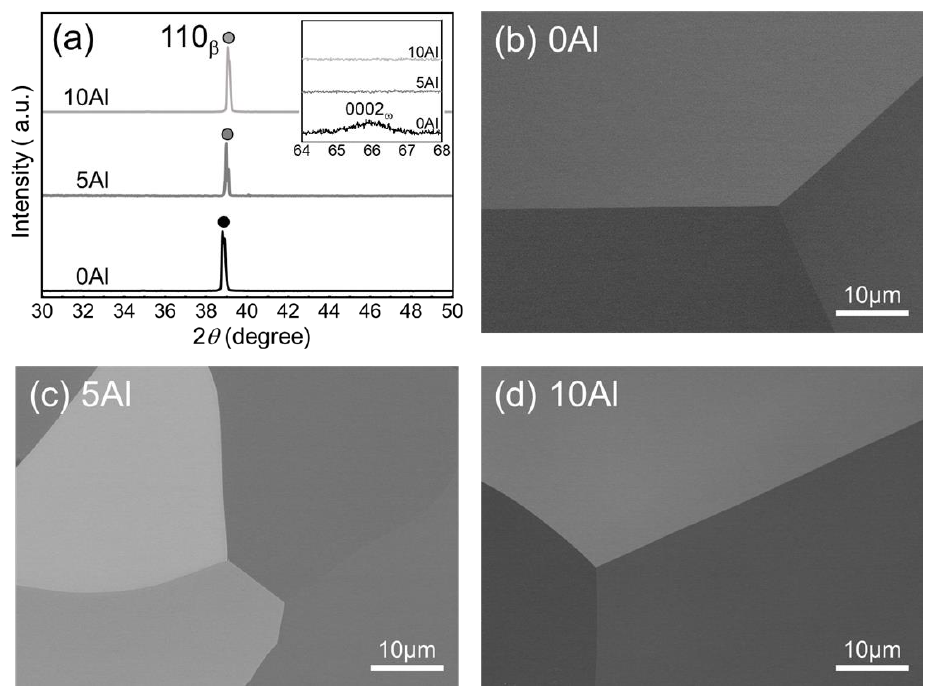
Figure 1. ( a ) XRD profiles of 0Al, 5Al, and 10Al solution-treated alloys (magnified X-ray diffraction patterns for three specimens from 2 θ = 64° to 68° are inserted in the top-right corner of ( a ) to reveal the diffraction peaks of ω phase). SEM images of ( b ) 0Al, ( c ) 5Al, and ( d ) 10Al. Dark-field (DF) images along with corresponding selected area diffraction patterns (SADPs) from the [110] β direction are shown in Figure 2 and a fine secondary phase was identified. Besides diffraction spots of the β phase, notwithstanding the Al amount, spots of the ω phase were further observed at 1/3 and 2/3 positions along the <112>* β direction in all SADPs. This ω phase was recognized as athermal ω (ω ath ), whose area fraction (AF) and size were evaluated by ImageJ 1.51k. Not surprisingly, the highest AF of 12.5% possessing a major axis of approximately 6.9 nm and a minor axis of approximately 2.3 nm of ω ath phase, was found in 0Al (Figure 2a). AF of 5.9% with an average size of 3.3 nm and AF of 2.8% with an average size of 3.1 nm of the ω ath phase were found in 5Al (Figure 2b) and 10Al (Figure 2c), respectively. It was thus concluded that the size and AF of the ω ath phase could be diminished with Al introduction. Moreover, spots of the ω ath phase in 0Al introduction (i.e., 5Al and 10Al), indicating that SADPs results agreed well with DF images.